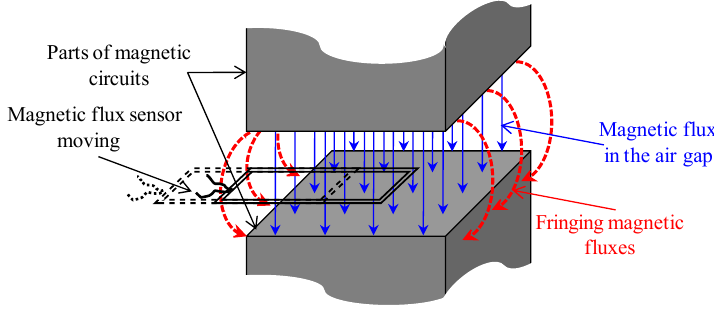
Figure 6. Fringing magnetic